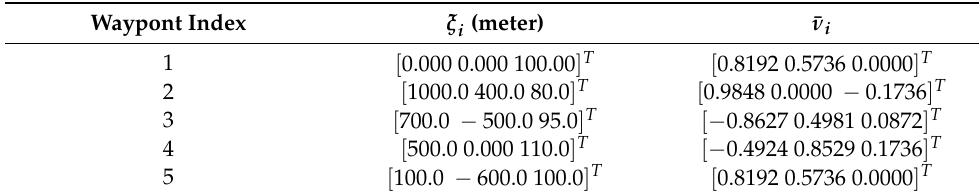
Table 5. The selected waypoints and heading unit vectors.